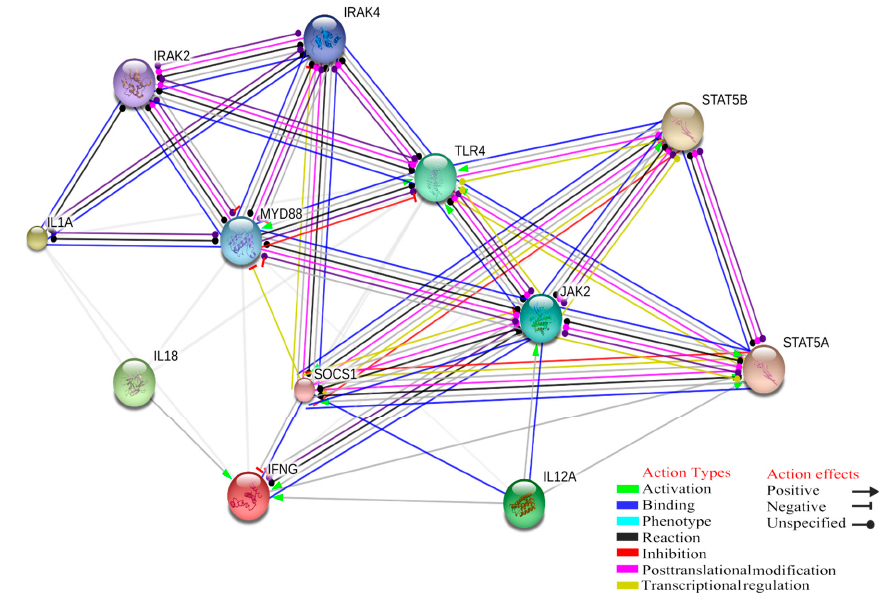
Figure 3. Interaction among MyD88, Toll-like receptor 4, IL-1 receptor signalling pathway in the innate immune response to tick-borne pathogens that could positively control the IFN- γ secretion; meanwhile, there is lack of IL-18 and IL-12 due to